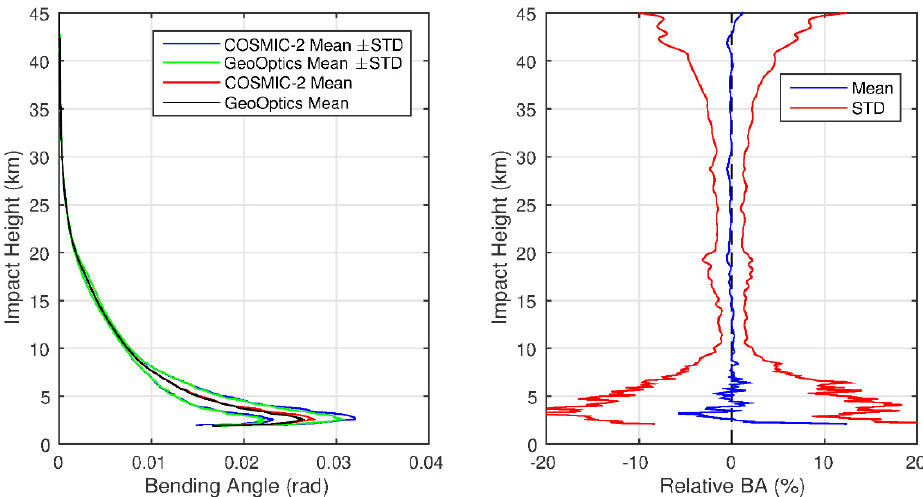
Figure 13. Bending angle profile comparison between COSMIC-2 and GeoOptics for GPS satellites over total 182 SRO cases: ( left ) mean bending angle profiles for COSMIC-2/GPS (red) and GeoOp- tics/GPS (black line) as well as mean ± standard deviation profiles (blue lines for COSMIC-2/GPS and green lines for GeoOptics/GPS) and ( right ) relative bending angle profile between GeoOptics and COSMIC-2 in terms of the mean difference (blue line) and standard deviation (red line).